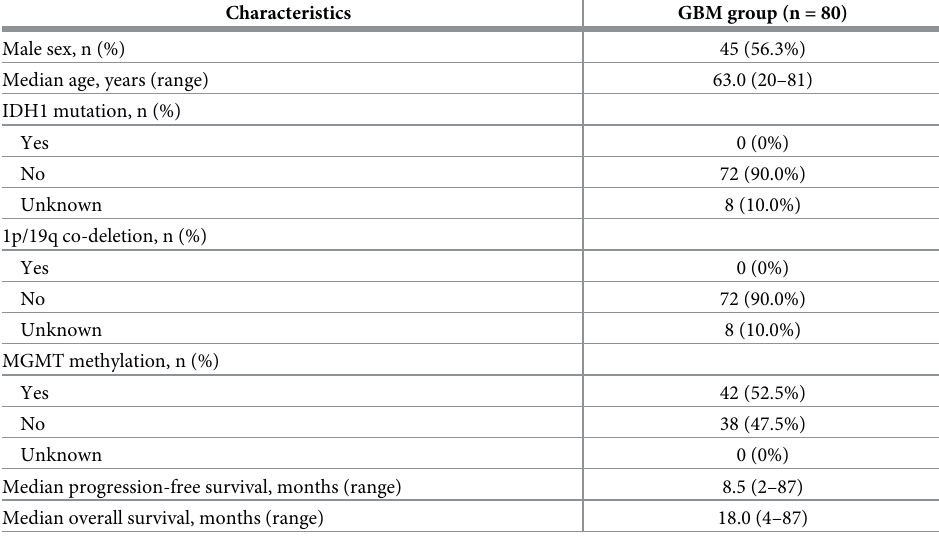
Table 1. Clinical characteristics of the GBM